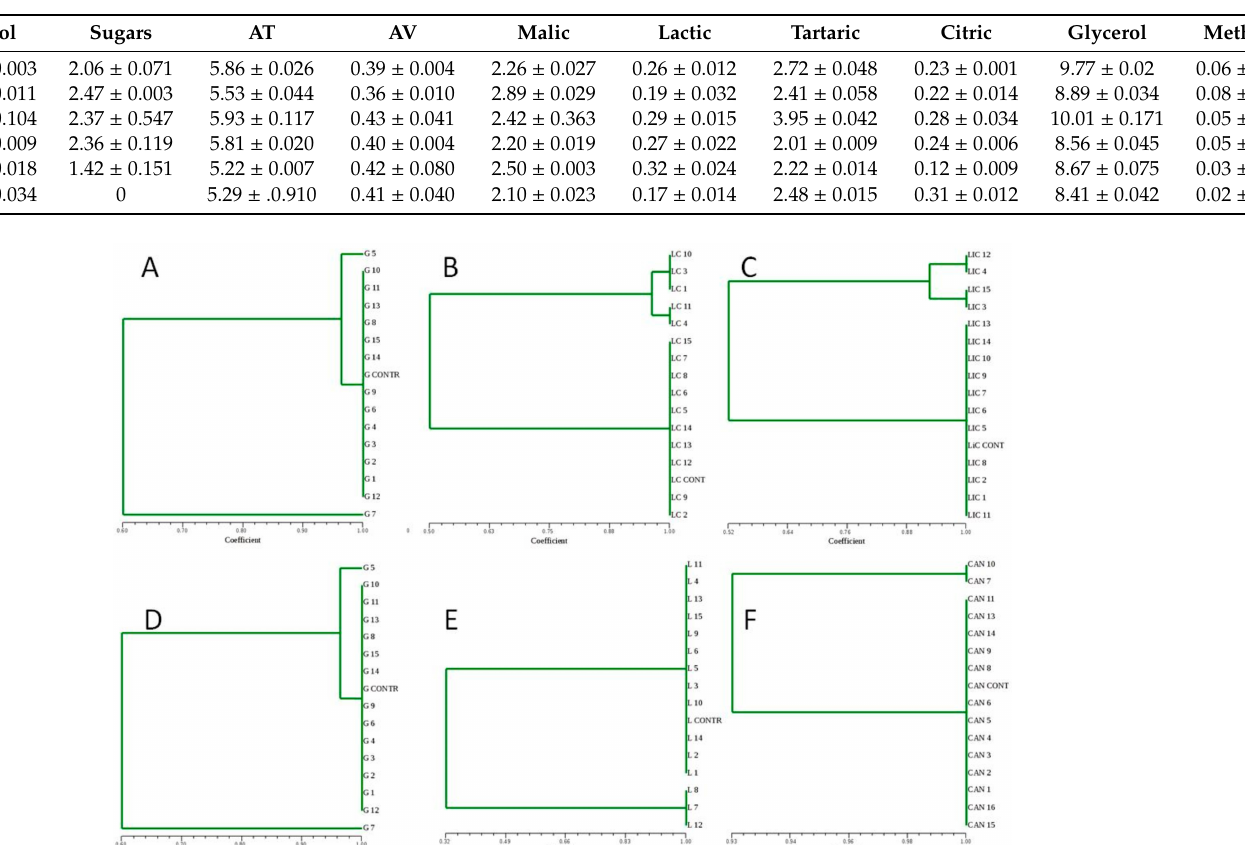
Table 1. Main physical and chemical parameters characterizing Primitivo (P) and Negroamaro (N) wines respectively produced by using the autochthonous yeast starters ITEM 14093 and ITEM 14077. The values are the means of two vinification at industrial scale. TA, Total Acidity; VA, Volatile Acidity. Alcohol concentration are expressed as g / 100mL; all other prameters are expressed as g / L.